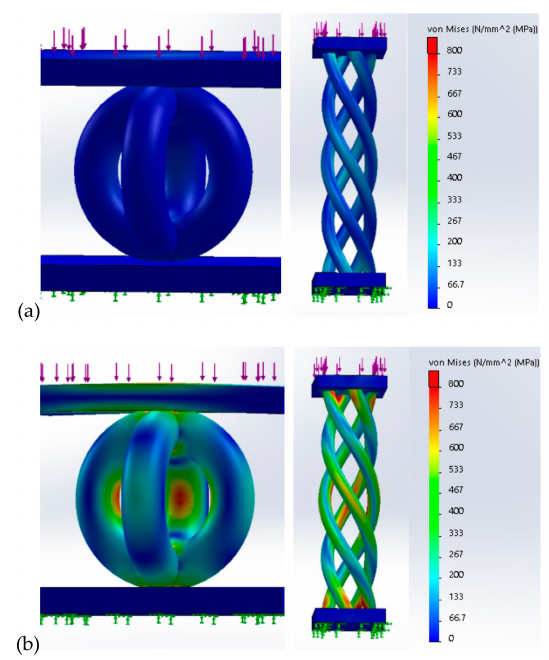
Figure 2. Von Mises stress distribution in PCI (right side) and PHS (left side) structure after applying a compressive load: ( a ) 10 N, ( b ) maxim force applied to reach the ultimate compressive strength of Ti6Al7Nb (approx. 790 MPa); 100 N for PCI structure, and 35 N for PHS